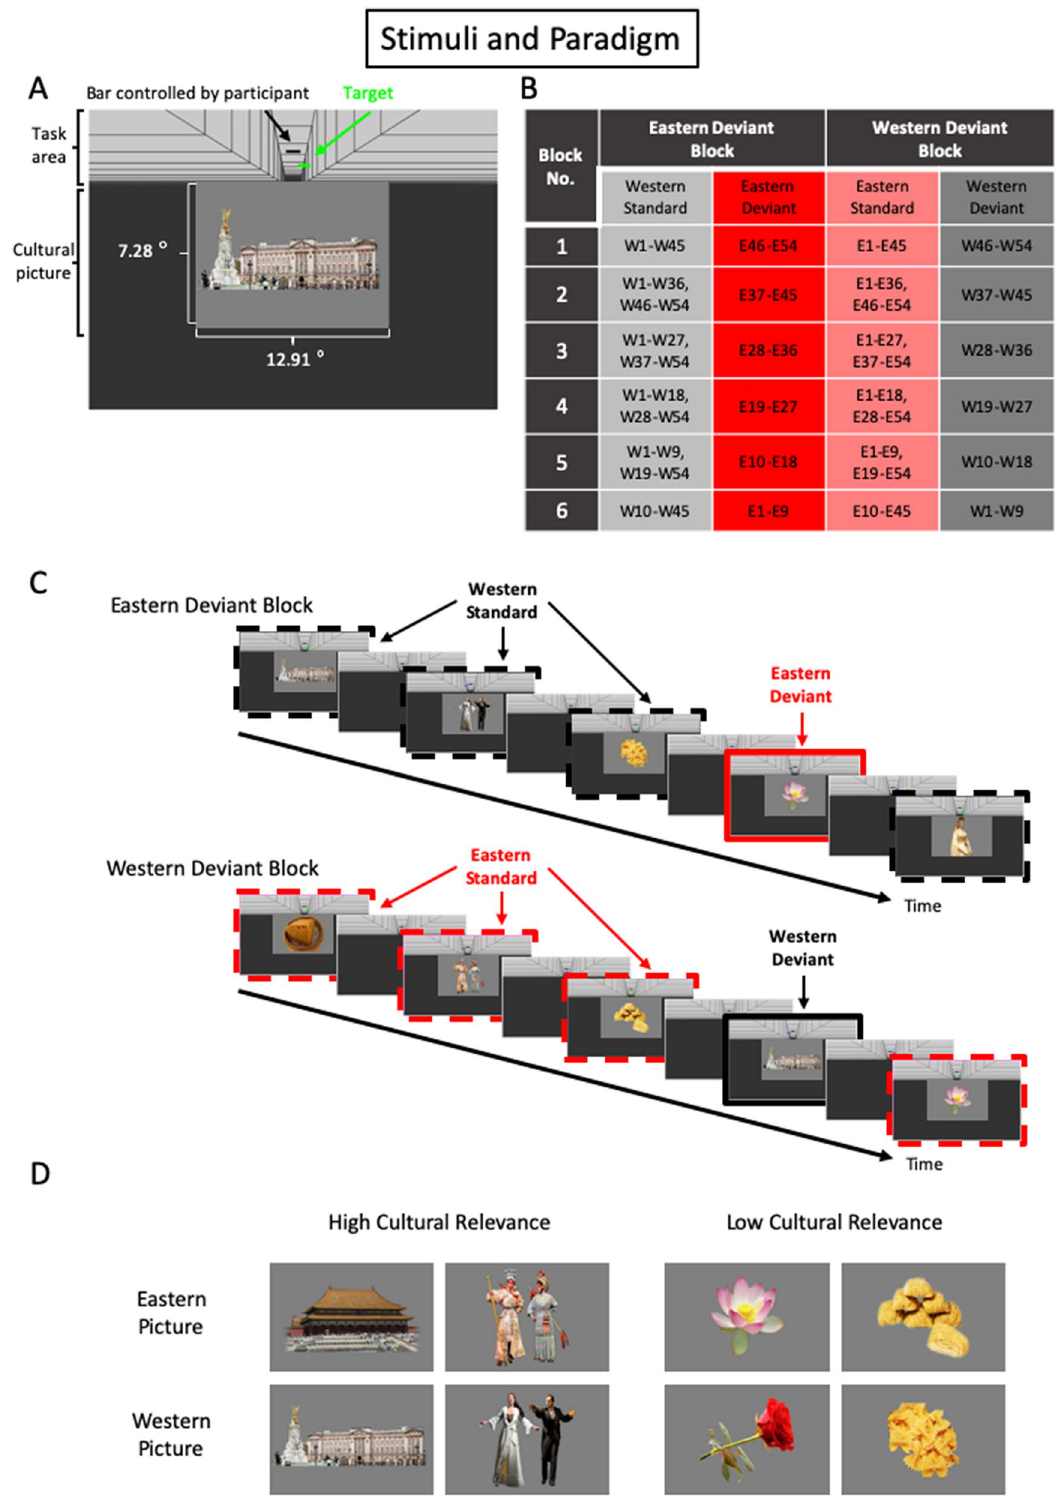
Figure 1. Stimulus properties and experimental design: ( A ) an illustration of the cultural picture (stimulus of the passive oddball paradigm) and the active video game task presented on the computer screen; ( B ) the organization of the 54 pairs of cultural pictures in the Eastern and Western deviant blocks (“E” indicates the Eastern pictures; “W” indicates the Western pictures; the number indicates a pair of pictures with the same theme); ( C ) schematic illustrations of the stimuli presented in the Eastern and Western deviant blocks; ( D ) examples of the Eastern and Western pictures with high or low cultural